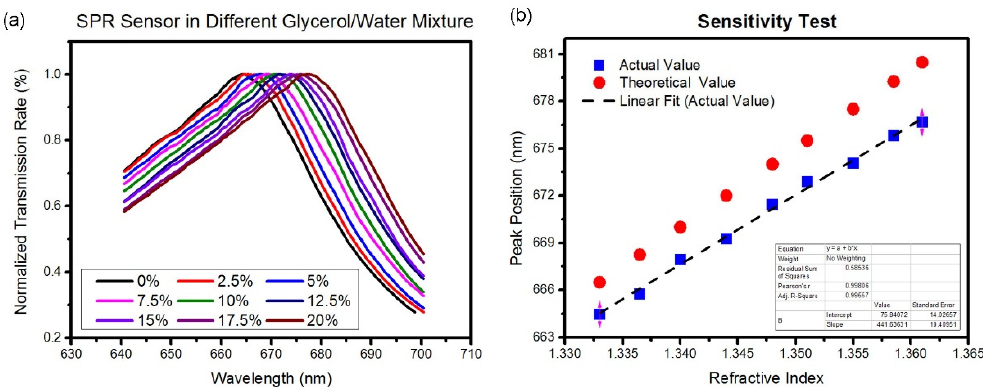
Figure 4. Sensitivity test. ( a ) Resonant spectra of the nanoslit SPR chip immersed in glycerol/water solutions with different refractive indices. ( b ) Curve fitting of the wavelengths of the resonant peaks.